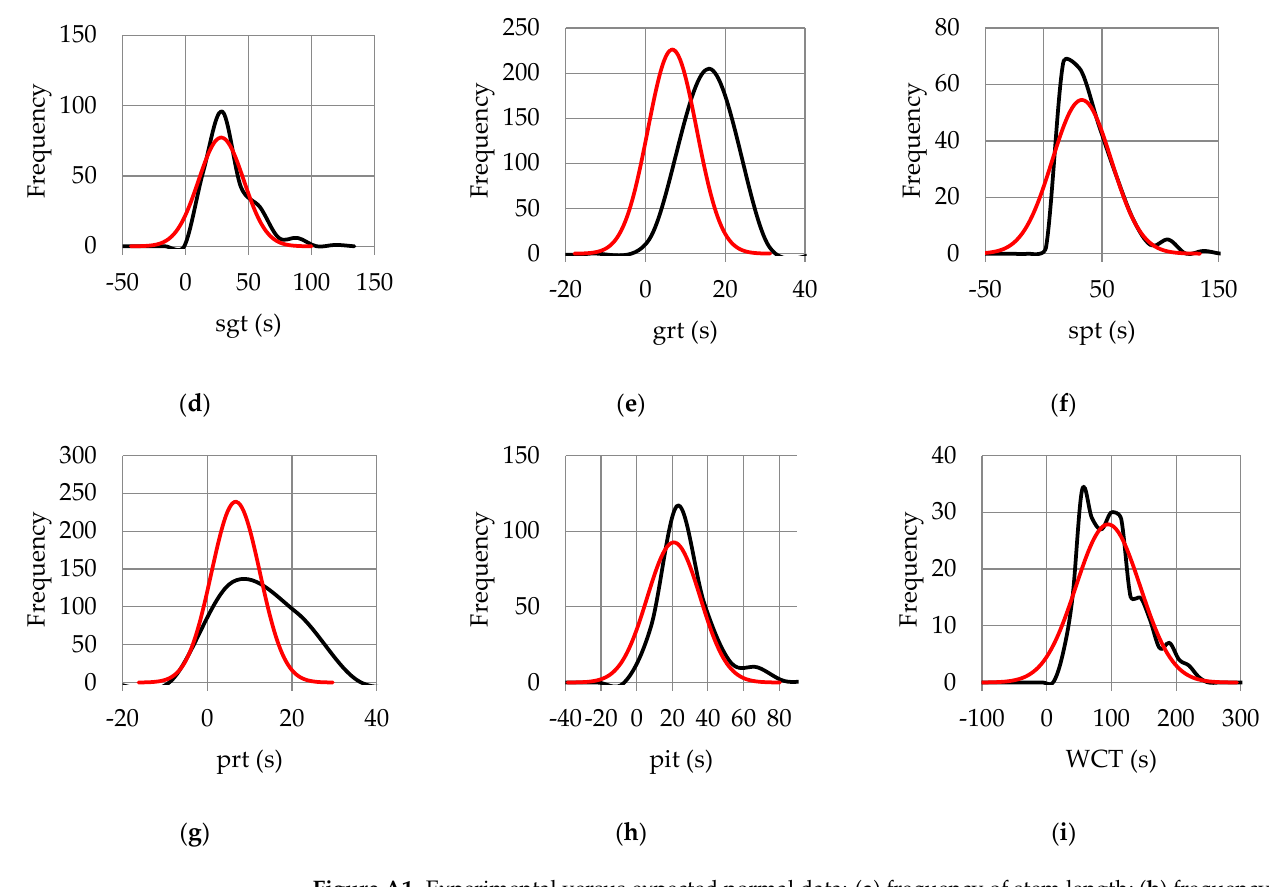
Figure A1. Experimental versus expected normal data: ( a ) frequency of stem length; ( b ) frequency of input volume; ( c ) frequency of number of processed logs; ( d ) frequency of swinging to grab time; ( e ) frequency of grabbing time; ( f ) frequency of swinging to process time; ( g ) frequency of processing time; ( h ) frequency of piling time; ( i ) frequency of work cycle time Legend: red lines stand for normal expected data, black lines stand for experimental data; Note: the graphs were built in Real Statistics by “match area” functionalities. None of the datasets has passed the normality check by Shapiro–Wilk or D’Agostino–Pearson tests.